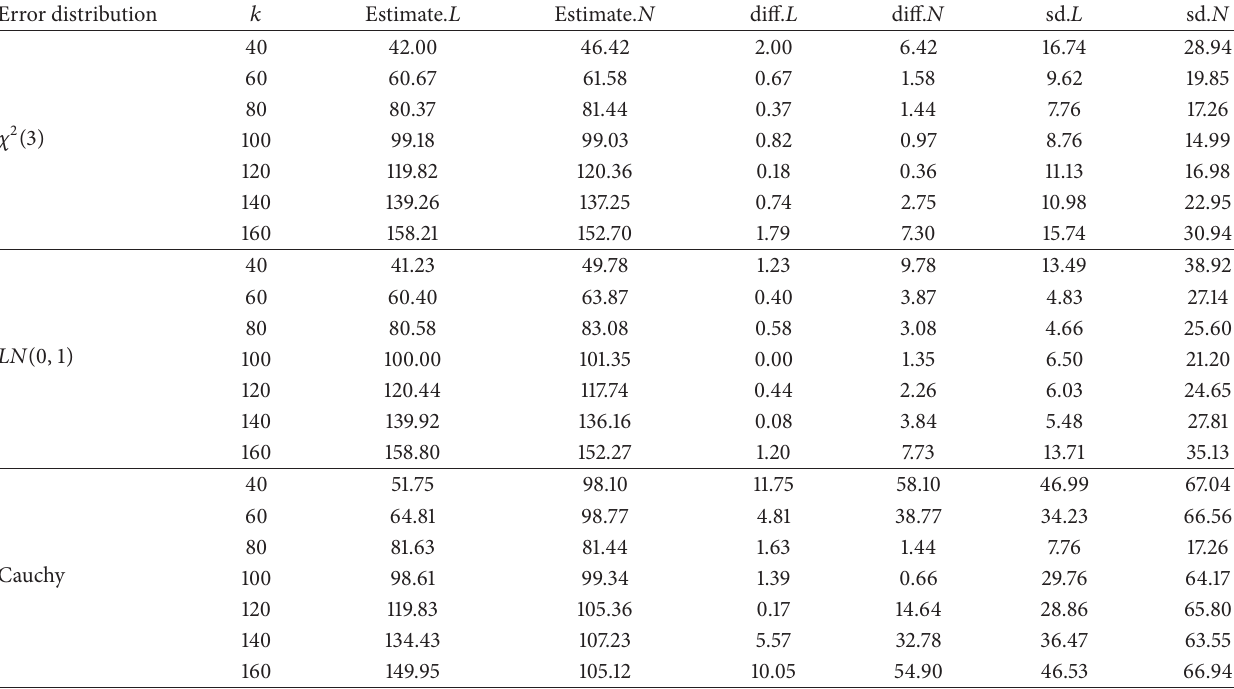
Table 2: Comparison of results for Laplace model and normal model based on 500 replications in Simulations 4–6. Error